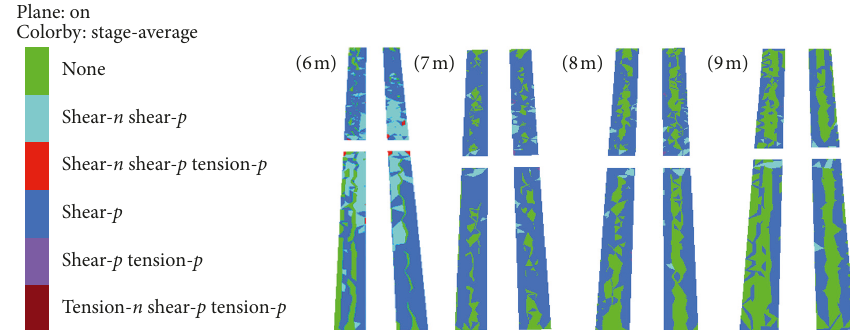
Figure 3: Plastic failure in the backfill after the third step.